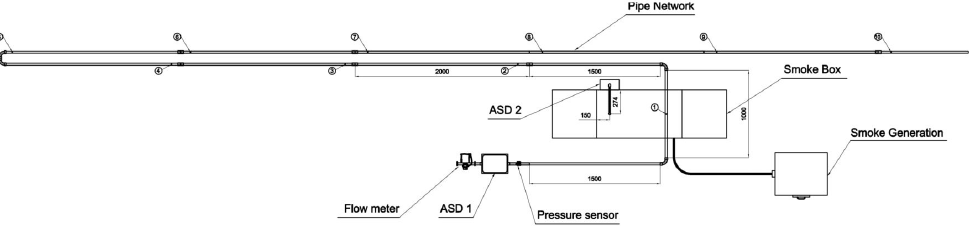
Figure 3. Schematic diagram of experiment used to determine the obscuration in aspirating smoke detection system.